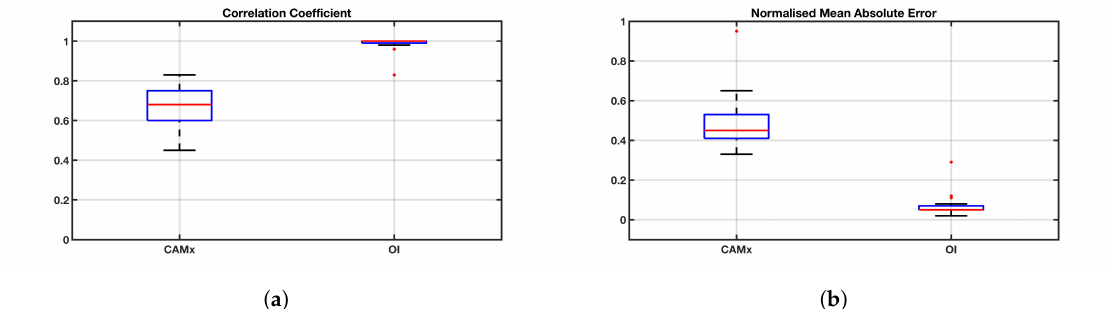
Figure 3. PM 10 daily mean concentration correlation coefficient ( a ) and normalised mean absolute error ( b ) for CAMx model and CAMx + optimal interpolation system.